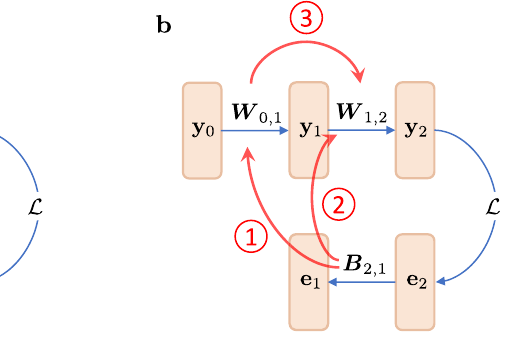
F 0 , information from B W ① , ③ ); meanwhile,thepresence 2,1 is communicated to 1,2 ( of F 2 sets up a new channel to directly communicate information from B 2,1 to W 1,2 ( ② ). The blue arrows depict information propagation through the forward and backward paths. The communications between feedback and feedforward path- ways are represented with red arrows.